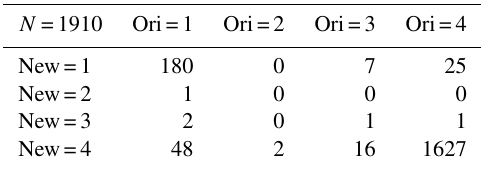
Table 1. Number of missing RCCM values remaining at the end of steps 1, 2 and 3 for the cases exhibited in this paper.